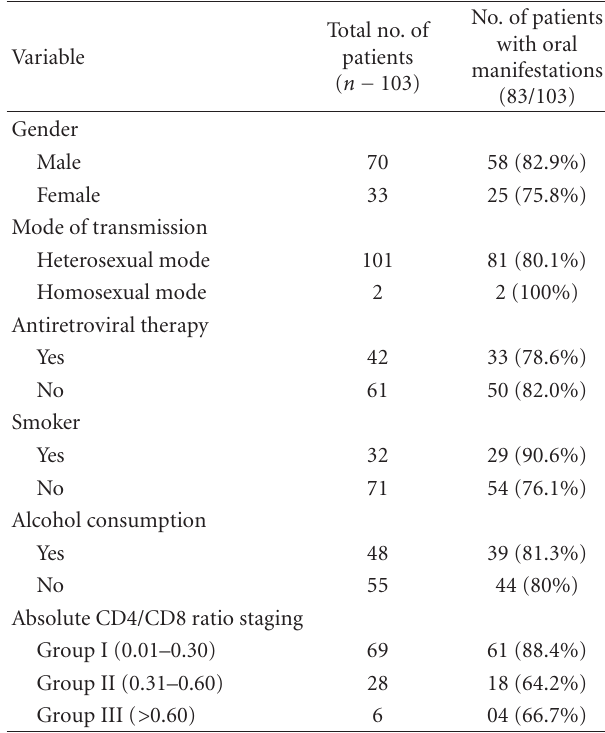
Table 1: Demographics and laboratory parameters of study